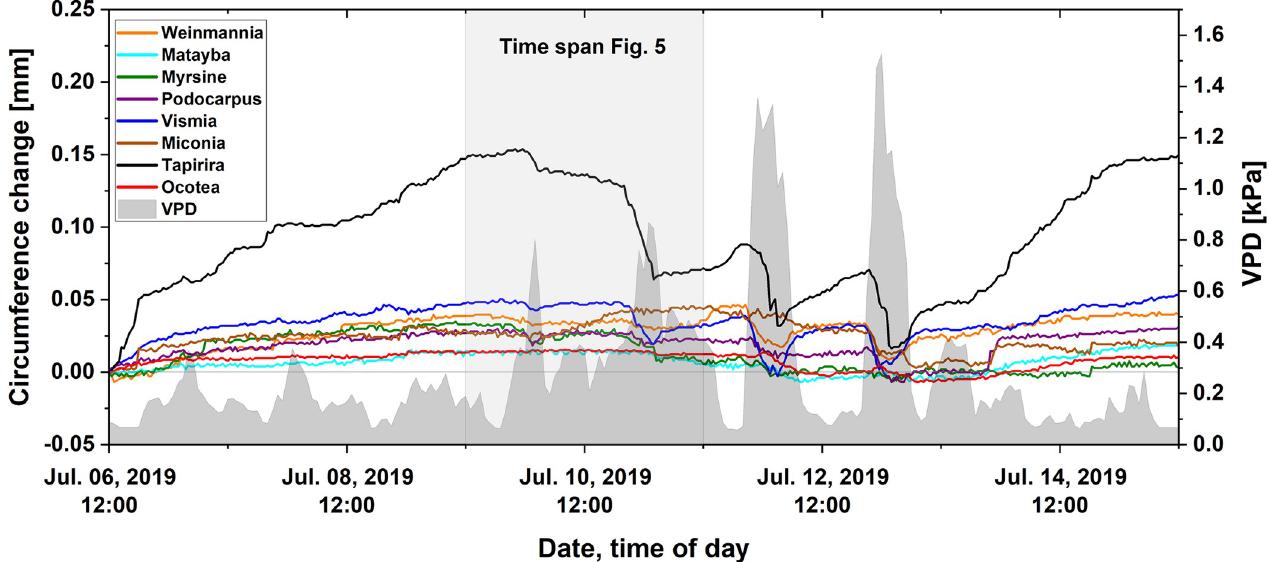
Fig 7. Stem circumference changes of different tree species during a short spell of dry weather. The grey background shows the atmospheric water vapor pressure deficit (VPD). The time span shown in Fig 5 is shaded (n = 29).